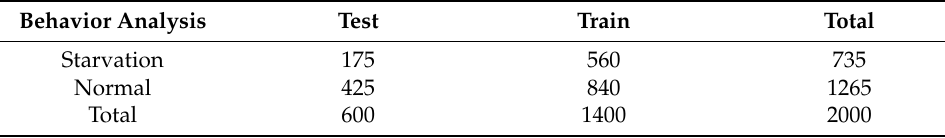
Table 1. Distribution of dataset images into training and testing for detection purposes.